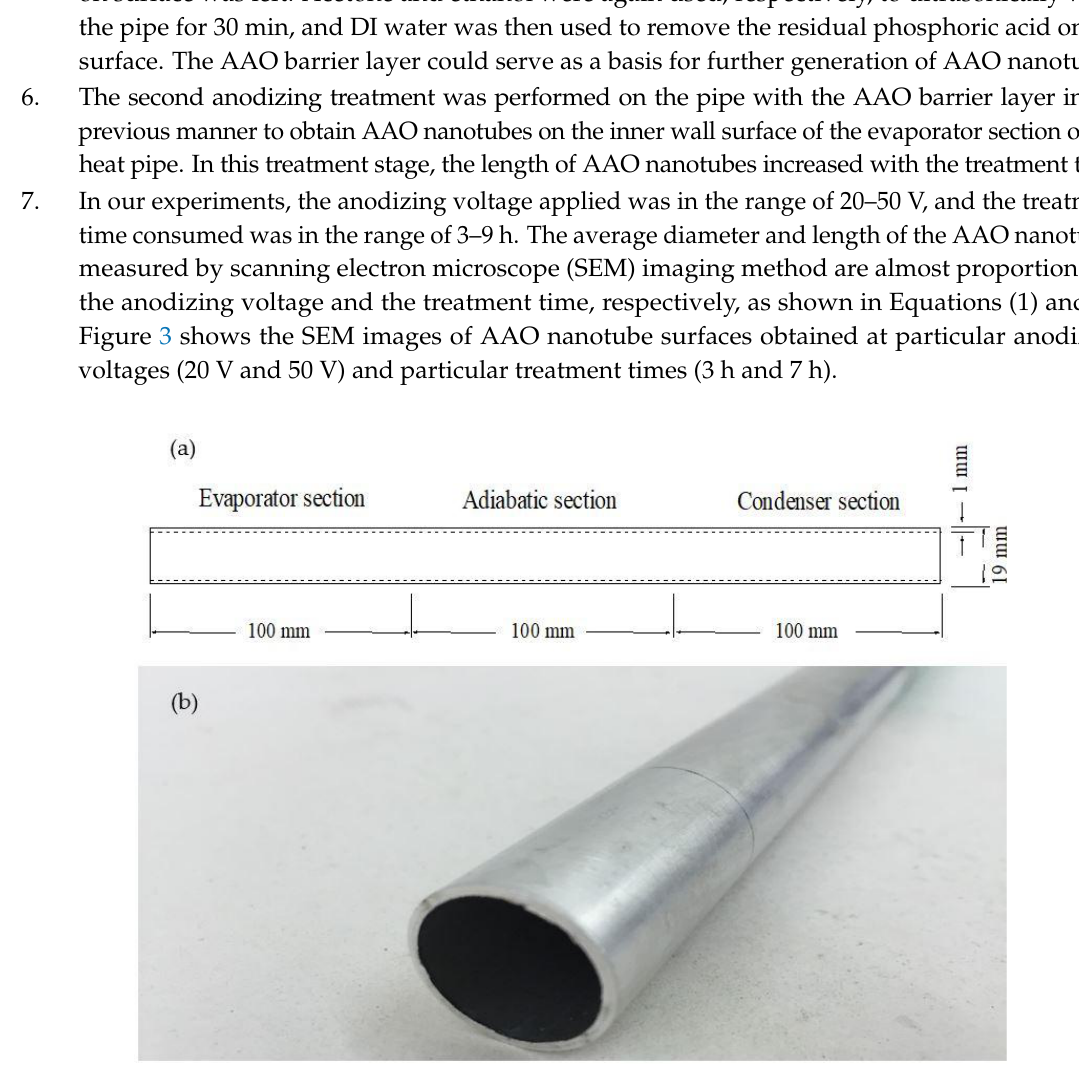
Figure 1. Aluminum alloy pipe: ( a ) Schematic drawing; and ( b ) photograph.